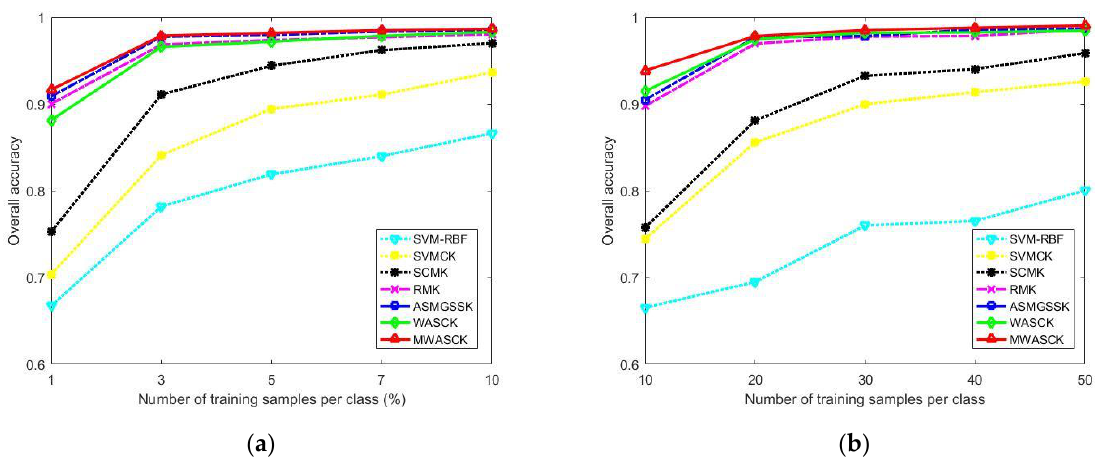
Figure 9. Effect of training sample numbers for different algorithms. ( a ) Indian Pines; ( b ) University of Pavia.